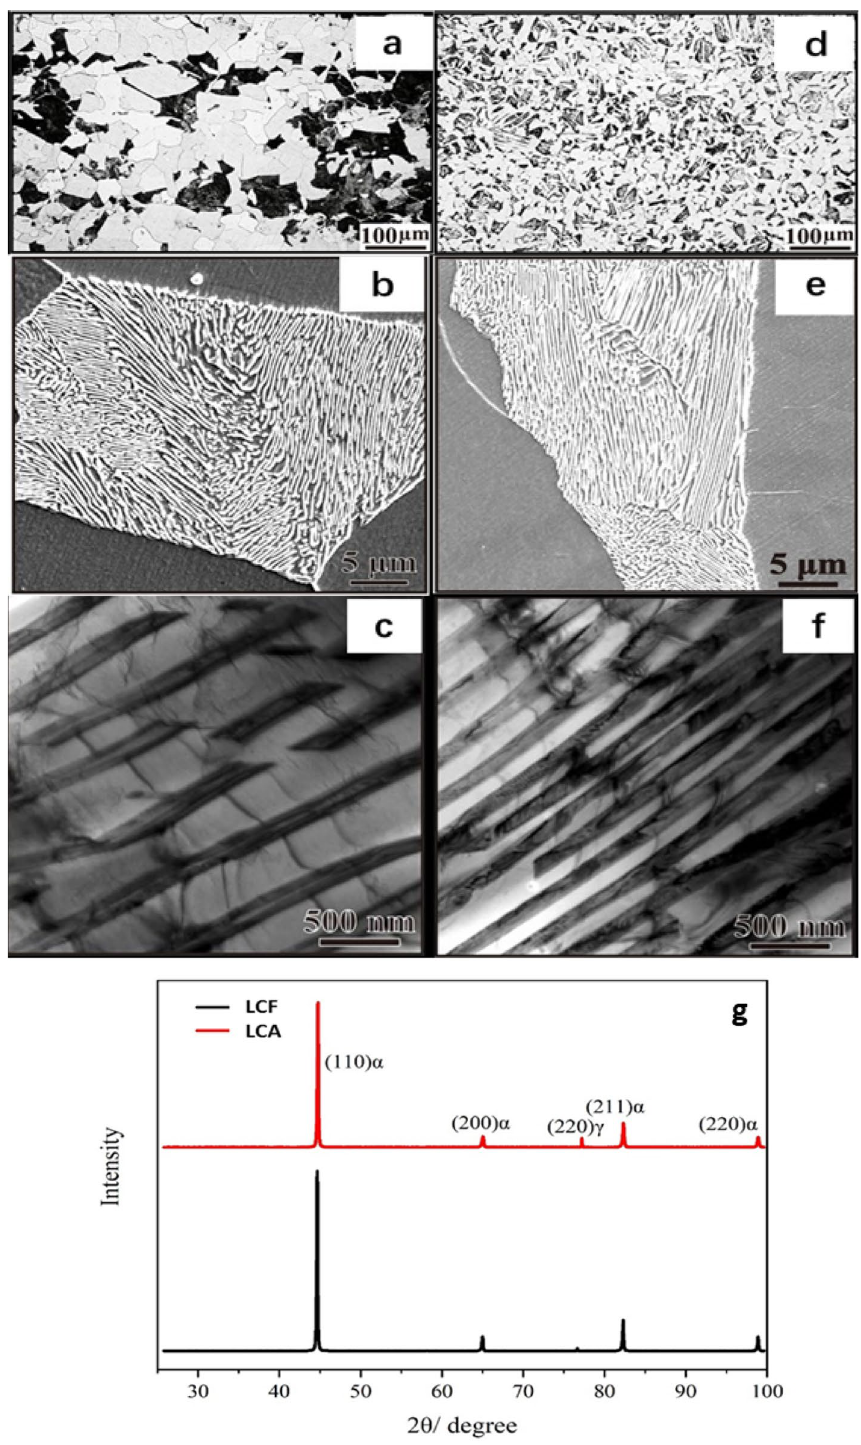
Figure 2. ( a ) An optical micrograph of LCF, dark regions are pearlites and white regions are the ferrite matrix; ( b ) A SEM image of LCF; ( c ) A TEM image of pearlite in LCF; ( d ) An optical micrograph of LCA; ( e ) A SEM image of LCA; ( f ) A TEM image of pearlite in LCA; ( g ) XRD patterns of LCF and LCA